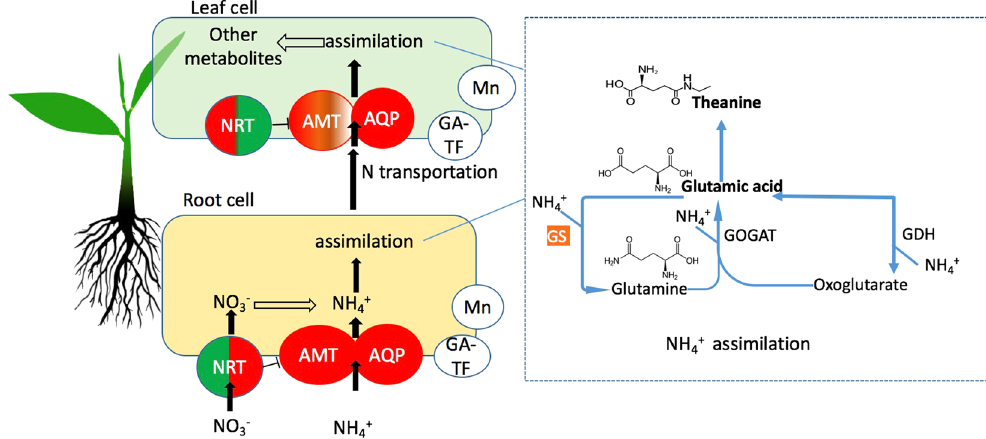
Figure 6. Nitrogen uptake, assimilation in roots and leaves of tea plant. Black and blue arrows represent the movement of ammonium and metabolite pathway, respectively. AMT , NRT , AQP , GS and GOGAT , represent the genes of the ammonium transporter, nitrate transporter, aquaporin protein, glutamine synthetase, and glutamic acid synthetase, respectively. Mn and GA-TF represent new identified manganese binding protein and gibberellin related transcript factors, respectively. Colors shading the protein show the up-regulated (red) or down-regulated (green) expression. Presence of both red and green colors shows varied regulation between the tea variety HJ and